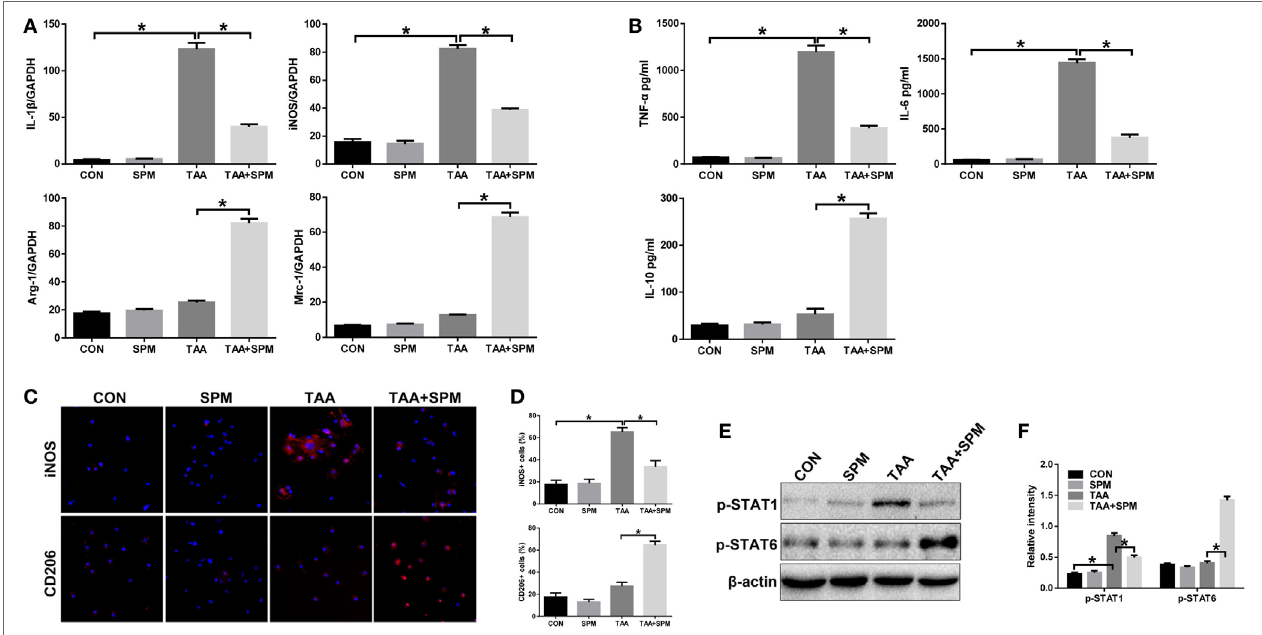
FigUre 3 | Spermine (SPM) regulates KC M1/M2 polarization in response to thioacetamide (TAA) treatment. Mice were subjected to SPM pretreatment and TAA administration as described in Section “Materials and Methods.” KCs were isolated from different experimental groups. M1 markers ( IL-1 β and iNOS ) and M2 markers ( Arg-1 and Mrc-1 ) of gene induction were analyzed by quantitative RT-PCR. Representative of three experiments (a) . Isolated KCs from different experimental groups were cultured for 6 h, and TNF- α , IL-6, and IL-10 protein were measured in the culture supernatant by ELISA [ (B) , n = 3/group]. Immunofluorescence staining of iNOS and CD206 in KCs (original magnification 20 × ). DAPI was used for nuclear staining [ (c) , n = 3/group]. Ratio of iNOS + and CD206 + cells in different experimental groups [ (D) , n = 3/group]. Intracellular p-STAT1, (P)STAT6, and β -actin protein levels were measured by Western blot. Representative of three experiments (e) . Relative density ratios of target proteins in different experimental groups compared to the control group (CON) were calculated [ (F) , n = 3/group] (* p <